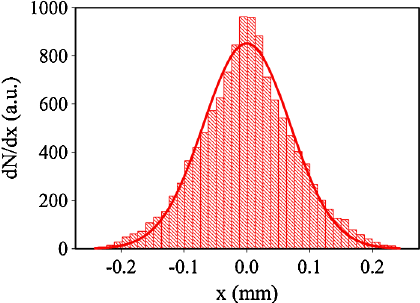
FIG. 7. Transversal density profile of the particle pulse.